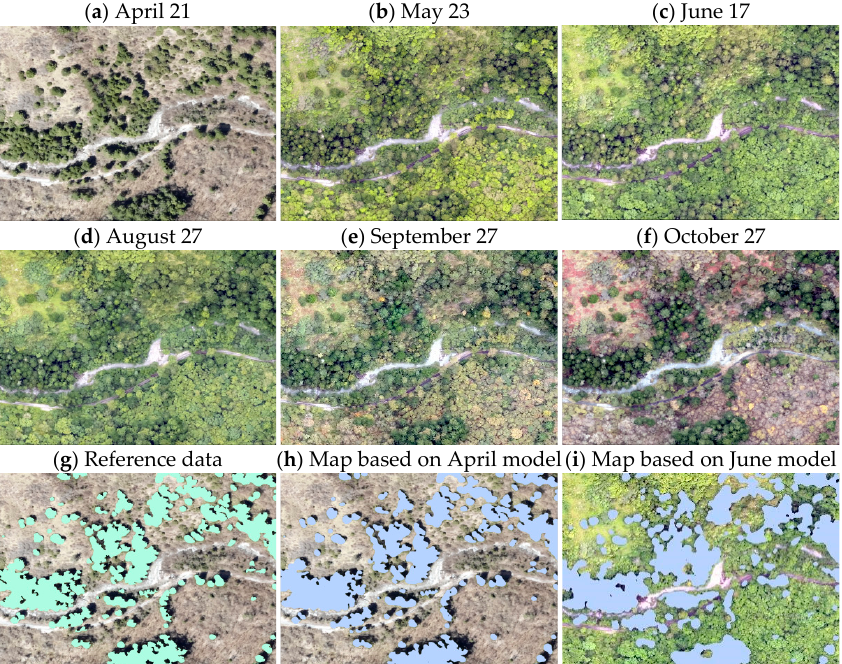
Figure 4. UAV-based RGB orthomosaics for different months and the associated Faxon fir identification map: ( a ) April 21, ( b ) May 23, ( c ) June 17, ( d ) August 27, ( e ) September 27, ( f ) and October 27 ( g ) manually labeled reference data in April; ( h ) identification map of RGB imagery on April model (highest accuracy), and ( i ) identification map of RGB imagery on June model (lowest accuracy).